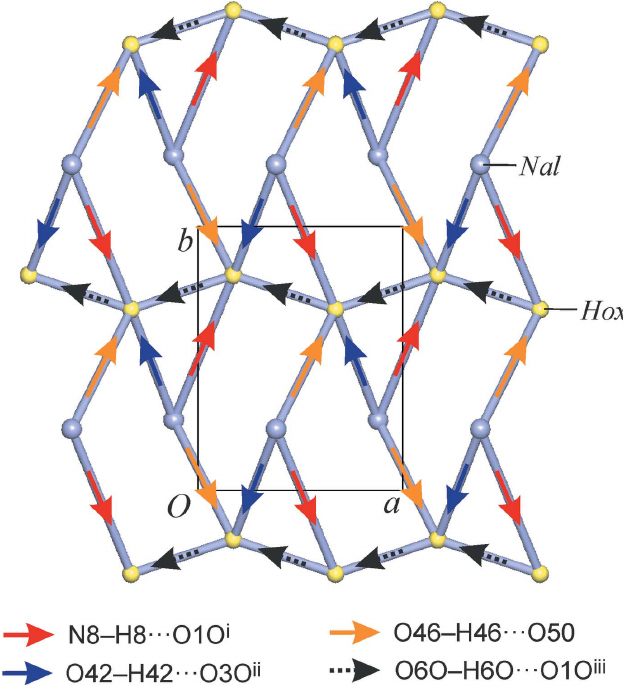
Figure 4 Topological representation in the manner proposed by Hursthouse et al. (2015) of the hydrogen-bonded layer structure with the 3,5 L50 topology (Nal = naloxegol, Hox = hydrogen oxalate). The net is viewed along the c axis. Note that the naloxegol nodes are placed at the centroid of the molecule rather than the center of its morphine scaffold.